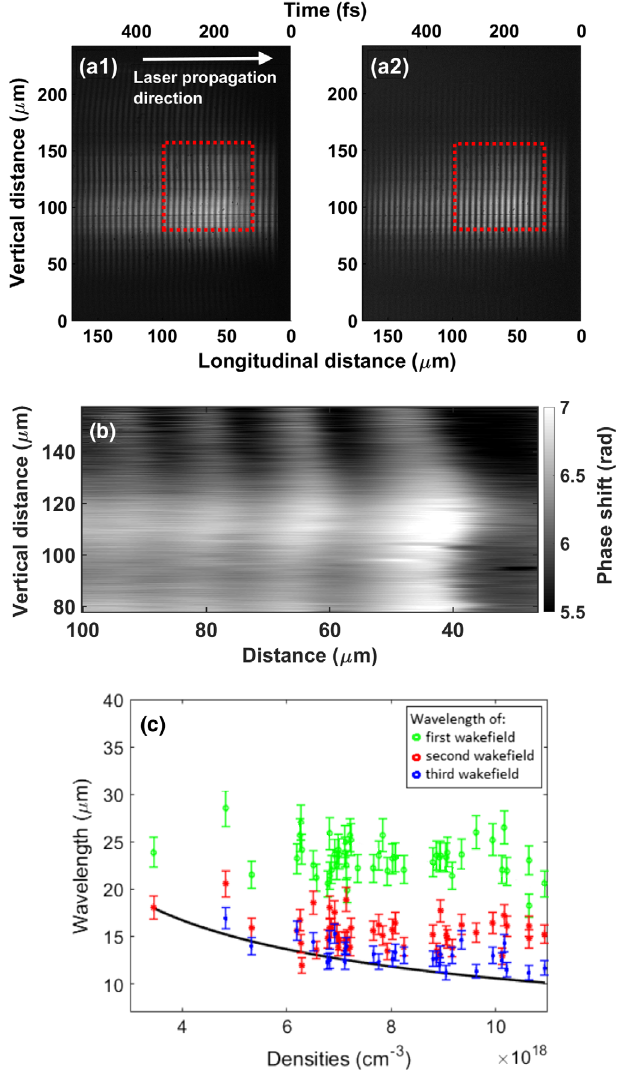
FIG. 2. (a) Spectrum of the image of the wakefield formed by the probe and reference pulses from which the phase shift across the x-y-plane was recovered. The drive pulse propagates to the right. The x-axis was mapped from laser wavelength to time (upper x-axis) using calibration data. This was multiplied by the approximated group velocity of the laser to convert to space (lower x-axis). The y-axis has an estimated systematic error of (cid:2) 10% due to the uncertainty of the magnification. (b) Processed data showing the unwrapped phase indicating the structure of the wakefield in a cluster plasma. Close-up of the area indicated by the red dashed rectangle in (a). (c) Measurement of the first (green), second (red), and third (blue) wakefield wavelengths as a function of the average plasma electron density measured by the transverse interferometry. The plot shows data from 30 separate laser shots. The black line shows the theoretical plasma wave- length for a uniform plasma. The data points were measured on-axis as the distance between successive minimum phase shifts. The error bars were obtained from the measurements for the calibration of the conversion parameter between pixel on CCD and time, b ¼ ð 1 . 81 (cid:2) 0 . 12 Þ pix =